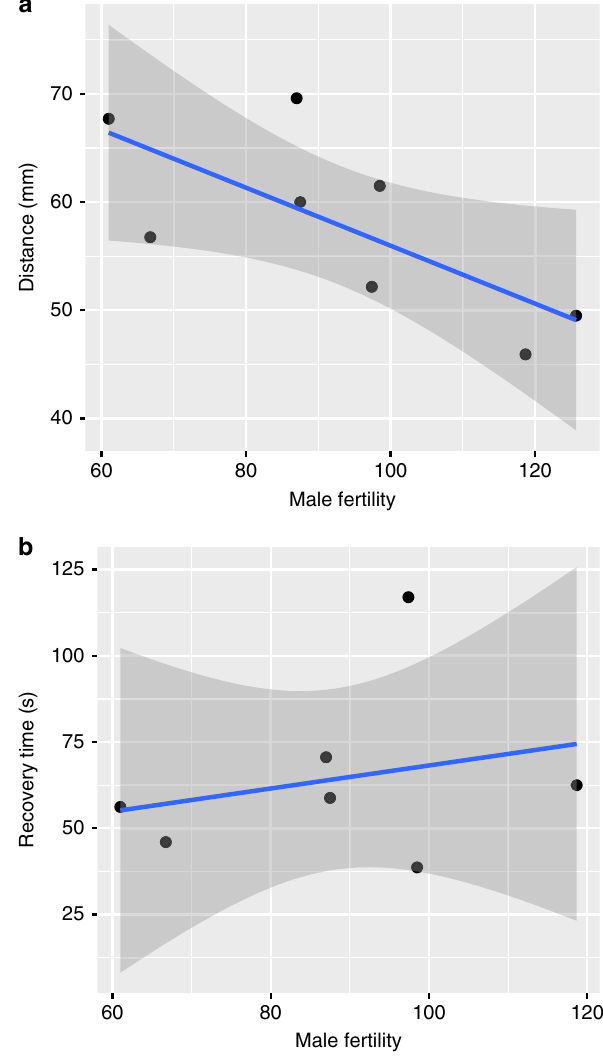
Fig. 3 Associations between late-life male fi tness and female health measures. a Male fertility at old age (35 days old) plotted against female performance in negative geotaxis assays (where a high number indicates a long distance travelled and high performance) (correlation coef fi cient: − 0.715, P = 0.046) and b female recovery time from anaesthesia (where a large number is a slow recovery and hence a negative indicator of performance) (correlation coef fi cient: 0.257, P = 0.577) in a sample of iso- female lines (standardised genotypes). Line averages and 95% con fi dence intervals are